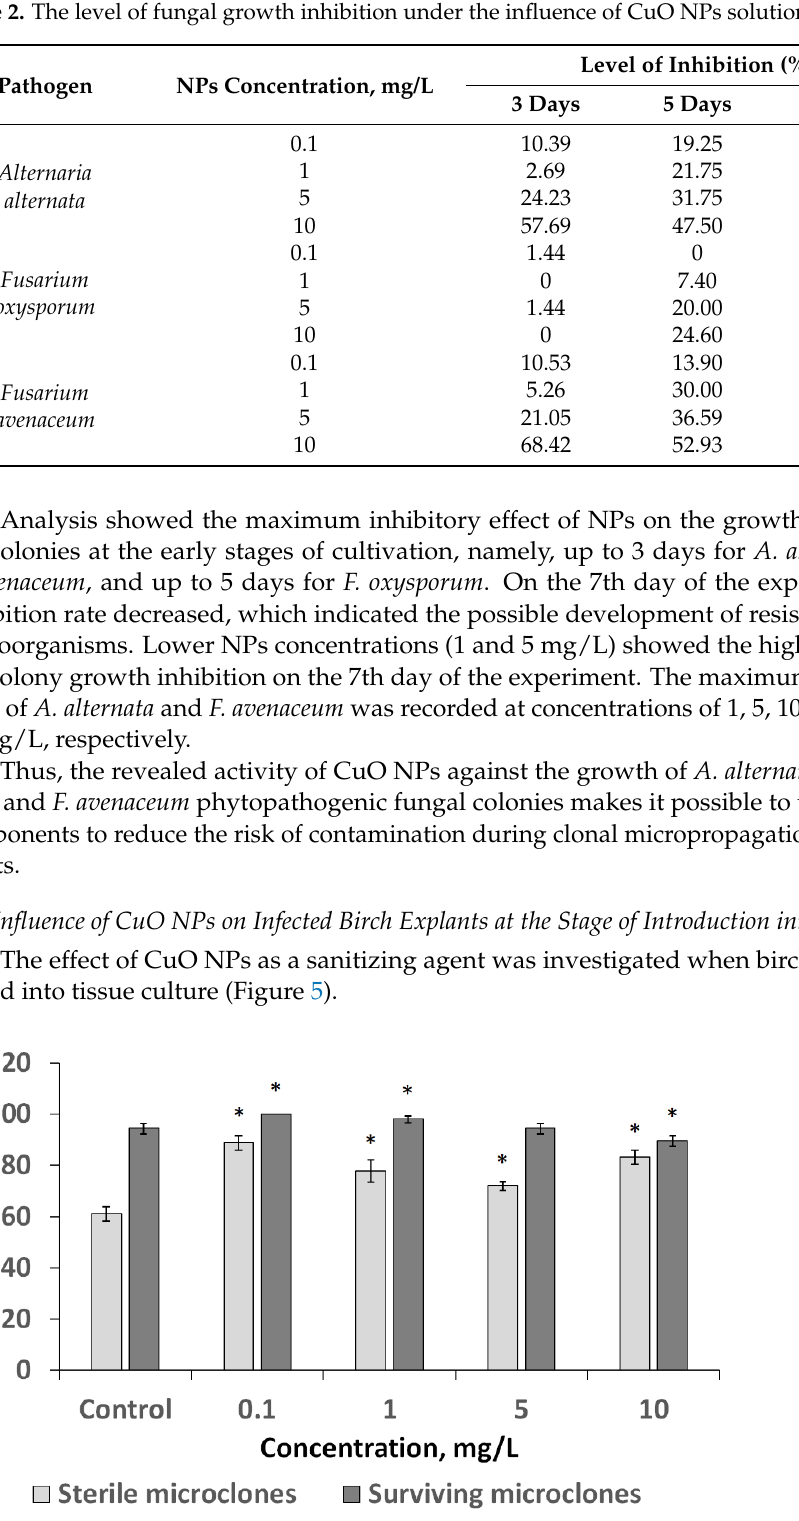
Figure 5. Influence of CuO NPs on explants of downy birch at the stage of introduction into culture. A significant increase in sterile microclones was shown using 0.1 mg/L NPs (* is significant deviation from control). With increasing concentration, this value decreased, but remained higher than the control.